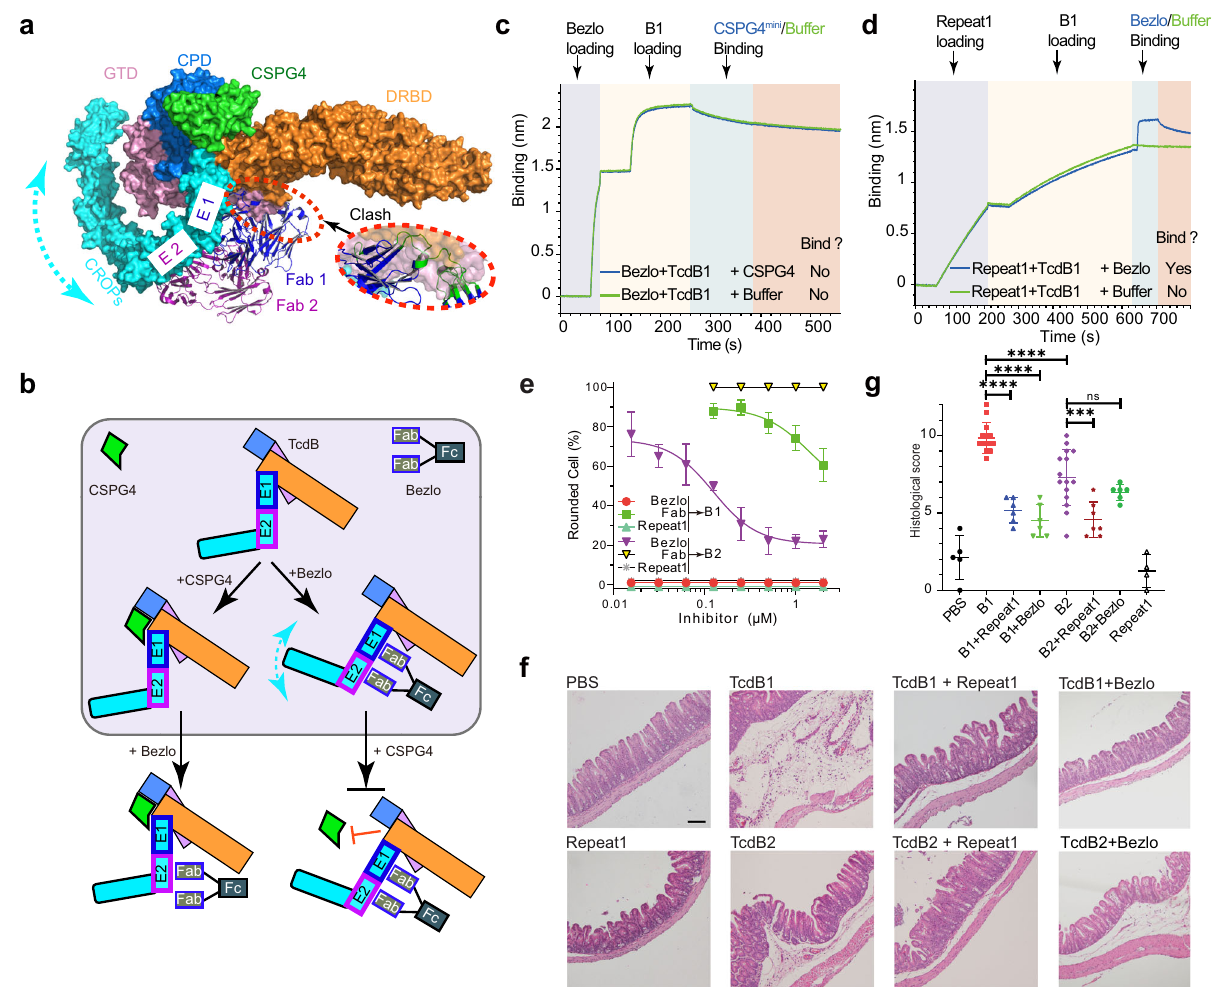
Fig. 6 Bezlotoxumab competes with CSPG4 in an allosteric manner. a A structure model showing the binding of CSPG4 and bezlotoxumab (PDB: 4NP4) in TcdB holotoxin (PDB: 6OQ5). TcdB holotoxin and CSPG4 Repeat1 are showing as surface models with the GTD, CPD, DRBD, CROPs, and CSPG4 Repeat1 colored in pink, blue, orange, cyan, and green, respectively. The two Fab fragments of bezlotoxumab are shown as cartoon models and colored blue and purple. E1 and E2 indicate the epitope-1 and epitope-2 for bezlotoxumab in TcdB. A close-up view into the con fl icting area between the Fab 1 bound at the E1 site and TcdB is shown in a red oval box, while the Fab residues that sterically clash with TcdB are colored in green. b A proposed model for allosteric interactions between CSPG4 and bezlotoxumab (Bezlo). c TcdB1 could not bind CSPG4 mini when it was prebound to the immobilized bezlotoxumab according to BLI assays. d Bezlotoxumab could still bind TcdB1 when it was prebound to the immobilized CSPG4 Repeat1. Sequential loading of different proteins to the biosensor is indicated by different background colors. e The protection effects of inhibitors against TcdB1 and TcdB2 were quanti fi ed by the cytopathic cell-rounding assay on HeLa cells. HeLa cells were incubated with TcdB1 (10 pM) or TcdB2 (100 pM) in the presence of serial-diluted bezlotoxumab (bezlo), its Fab (Fab), or Repeat1-Fc (Repeat1). Percentage of rounded cells are plotted by inhibitor concentrations at 6 h. Error bars indicate mean ± sd ( n = 3 biologically independent experiments). f , g The protective effects of Repeat1-Fc and bezlotoxumab against TcdB1 and TcdB2 were examined in vivo using the cecum injection assay. TcdB1 (6 µ g), TcdB2 (6 µ g), TcdB1 or TcdB2 with Repeat1-Fc (30 µ g) or bezlotoxumab (52 µ g), Repeat1- Fc alone (30 µ g), or the PBS control was injected into the cecum of CD1 mice in vivo. The cecum tissues were harvested 6 h later, and the representative H&E staining (scale bar represents 100 µ m, PBS n = 5, B1 n = 13, B1 + Repeat1 n = 6, B1 + Bezlo n = 6, B2 n = 15, B2 + Repeat1 n = 7, B2 + Bezlo n = 6, Repeat1 n = 4) ( f ) and the histological scores (error bars indicate mean ± SEM, PBS n = 5, B1 n = 13, B1 + Repeat1 n = 6, B1 + Bezlo n = 6, B2 n = 15, B2 + Repeat1 n = 7, B2 + Bezlo n = 6, Repeat1 n = 4) ( g ) are shown. p values were calculated by post hoc analysis of a one-way ANOVA using Holm-Sidak ’